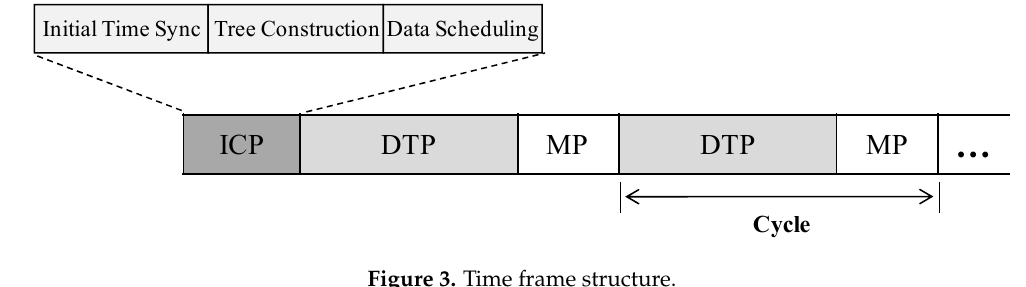
Figure 3. Time frame structure.